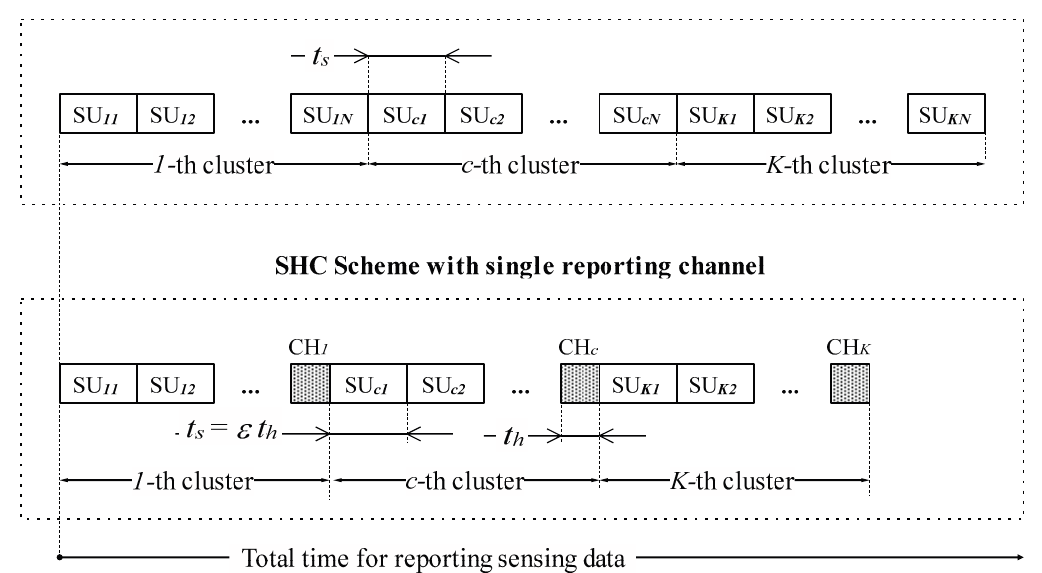
Figure 2. Reporting mechanism of SHC scheme, in which t s denotes the time for sending a test statistic, t h denotes the time for sending a one bit decision, ε is correlation coefficient between t s and t h